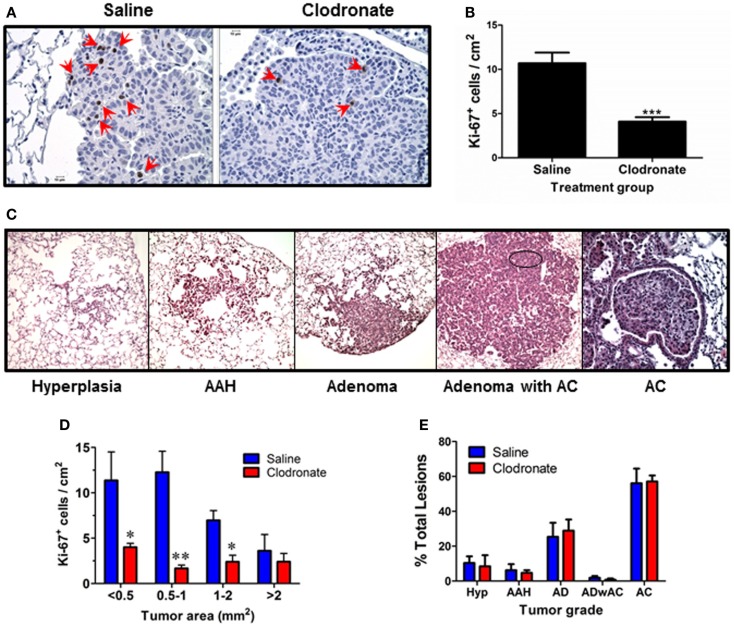
Effects of clodronate treatment on tumor growth and progression. (A) Representative Ki67 IHC on tissue sections from similar sized tumors from vehicle (left) and clodronate (right) treated mice (400× final magnification). Red arrows point to positively stained tumor cells. (B) Ki-67 index was calculated as the average number of Ki-67+ cells/cm2 tumor area for each tumor in each group (mean ± SEM, **p < 0.01 vs. vehicle). (C) Representative examples of each tumor grade (400× final magnification). (D) Ki67 index as a function of tumor size at 44 weeks in saline and clodronate-treated mouse lung tumors. Significant differences were seen in the number of Ki67+ cells in the smaller lung tumors. (E) Percent of each lesion type was calculated/mouse. No significant differences were detected.